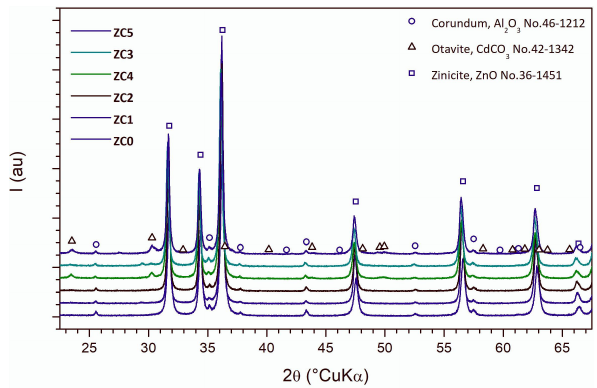
Figure 1: XRD patterns of mechanochemically prepared samples with various portions of dopant.